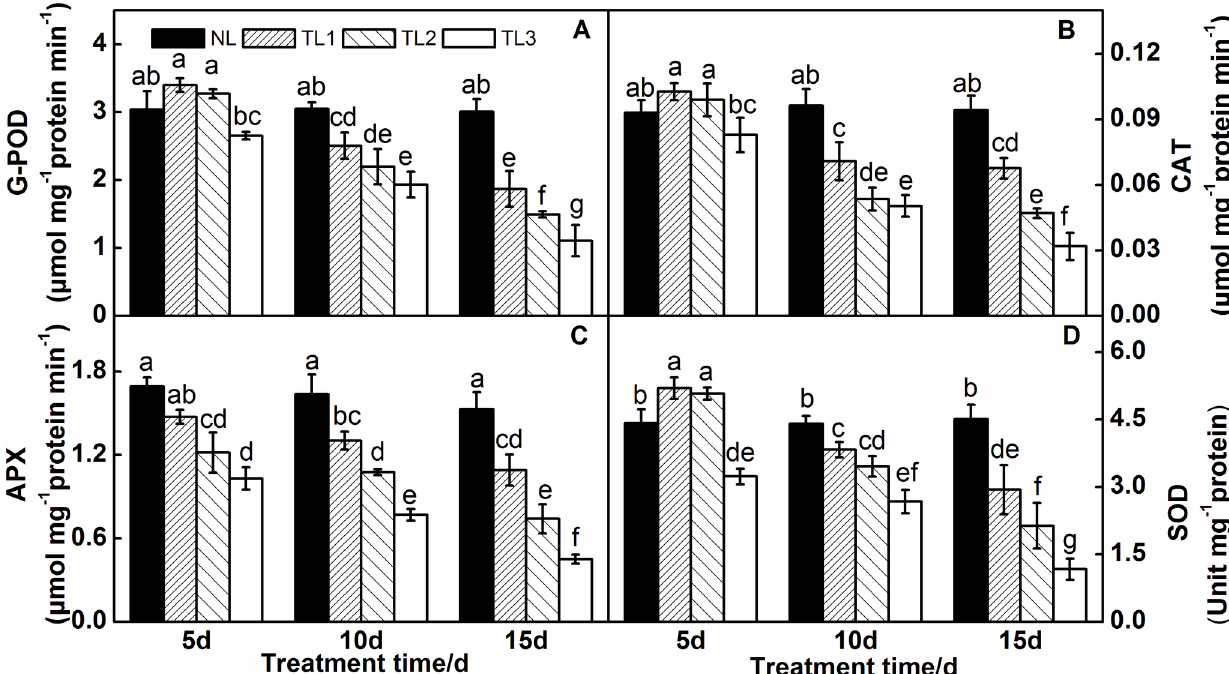
Fig 5. Effects of low light on guaiacol peroxidase(G-POD) (A), catalase(CAT) (B), ascorbate peroxidase (APX) (C) and superoxide dismutase (SOD) (D) activities in the leaves of purplepak-choi seedlings. The data are the mean of three replicates,with SDs shown as vertical bars . The means marked with different letters indicate significantdifferences betweentreatments at p < 0.05,as determinedwith Duncan’smultiple range test. Different lower-caseletters at each time point indicatesignificant differences betweentreatments.